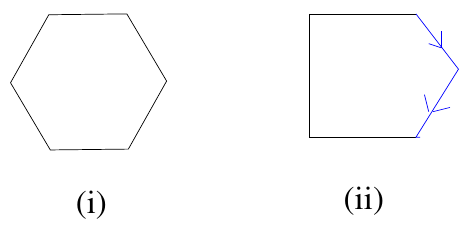
Figure 1 . The graphs (i) E 6 and (ii) R 3 ; 2